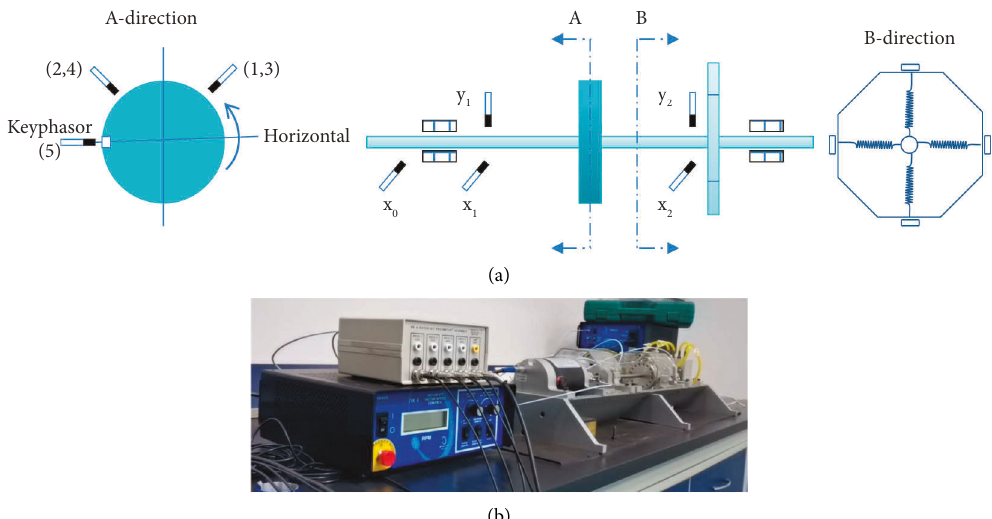
Figure 8: Bently Nevada Rotor Kit with a specific force loading device. (a) The structure chart and (b) the physical